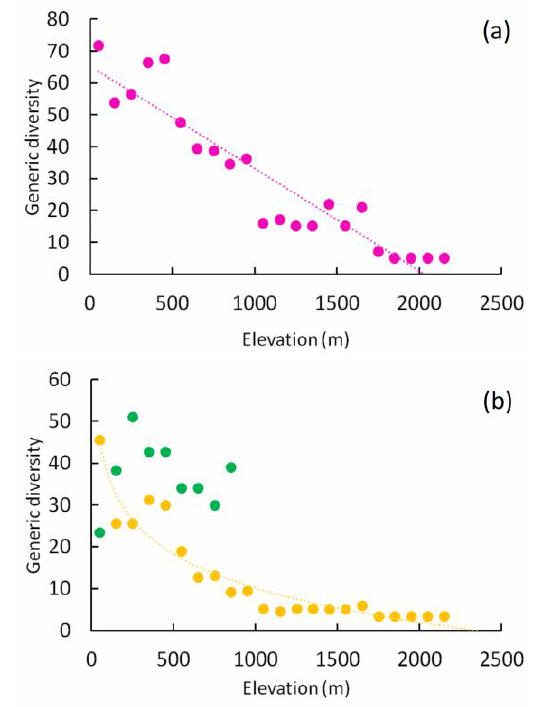
Figure 2. Relationships between generic diversity and elevation (in meters) for the total number of species (panel a , pink circles) and for geophilous (yellow circles) and xylophilous (green circles) species separately (panel b ). Dotted lines are regression lines (linear function in panel a ; semilog function in panel b ). Regression equations and goodness-of fit values are given in Table 1.